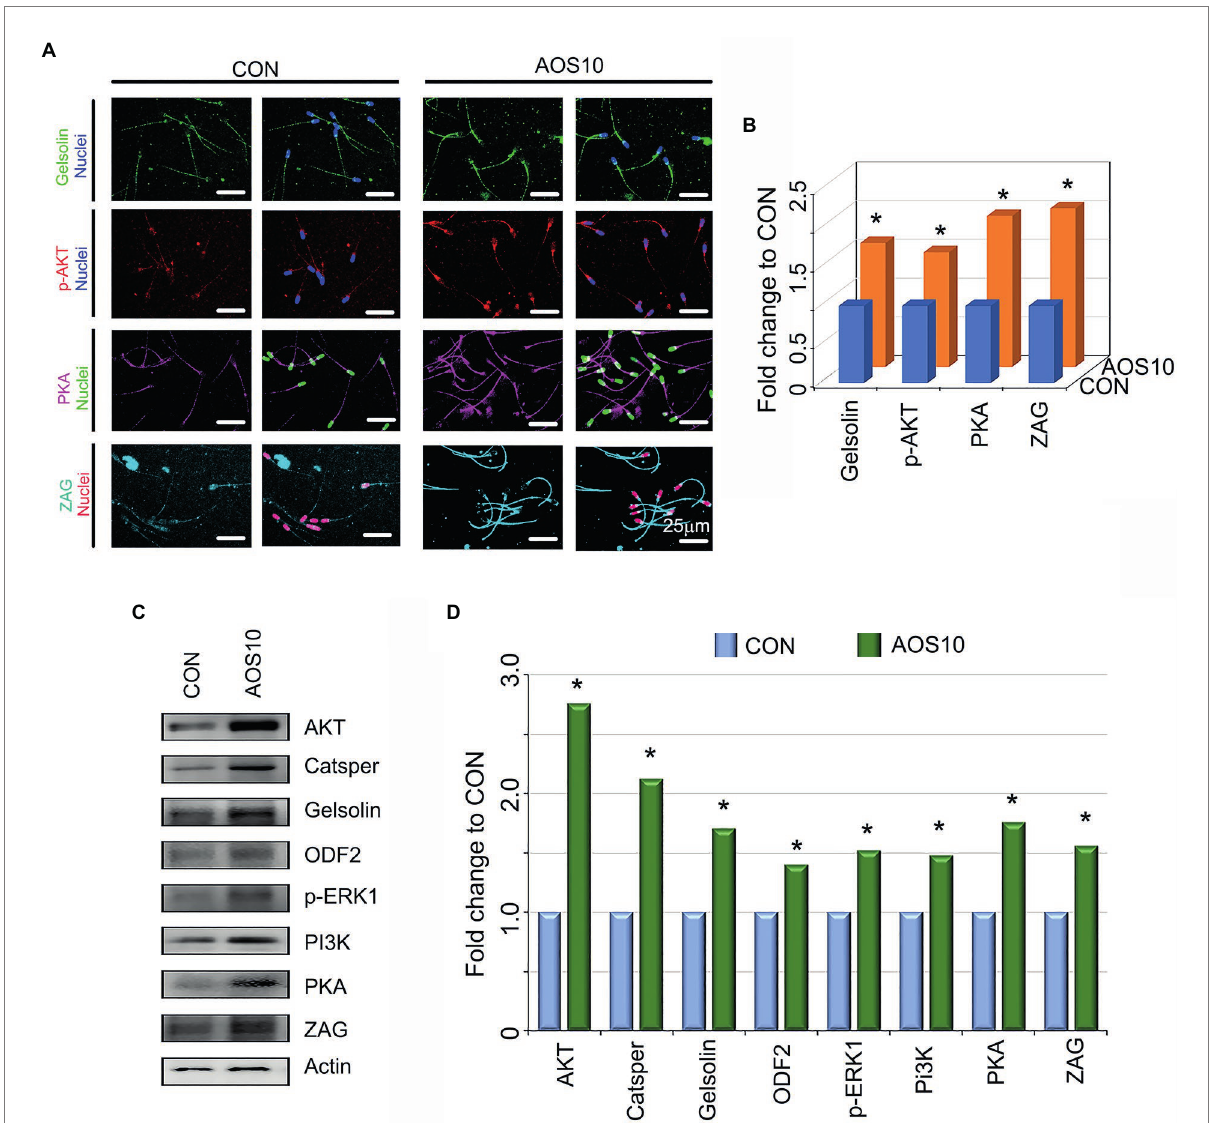
FIGURE 2 The influence of AOS on the protein expression in boar sperm. (A) Sperm protein levels of important genes for semen quality as detected by immunofluorescence staining. N > 6. (B) Quantitative data for immunofluorescence staining. Y-axis = fold change to CON, X-axis = treatment group (mg/kg body weight). * p < 0.05. (C) Sperm protein levels of important genes for semen quality as detected by Western blotting. N > 3. (D) Quantitative data for western blotting analysis. Y-axis = fold change to CON, X-axis = treatment group (mg/kg body weight). * p <